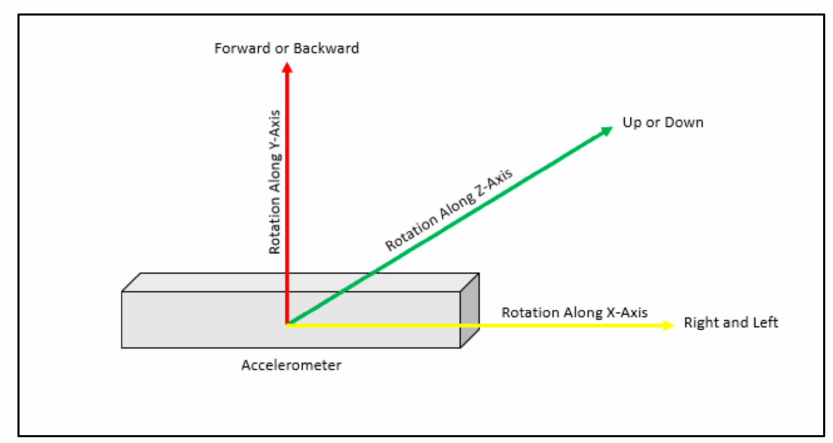
Figure 7. Accelerometer